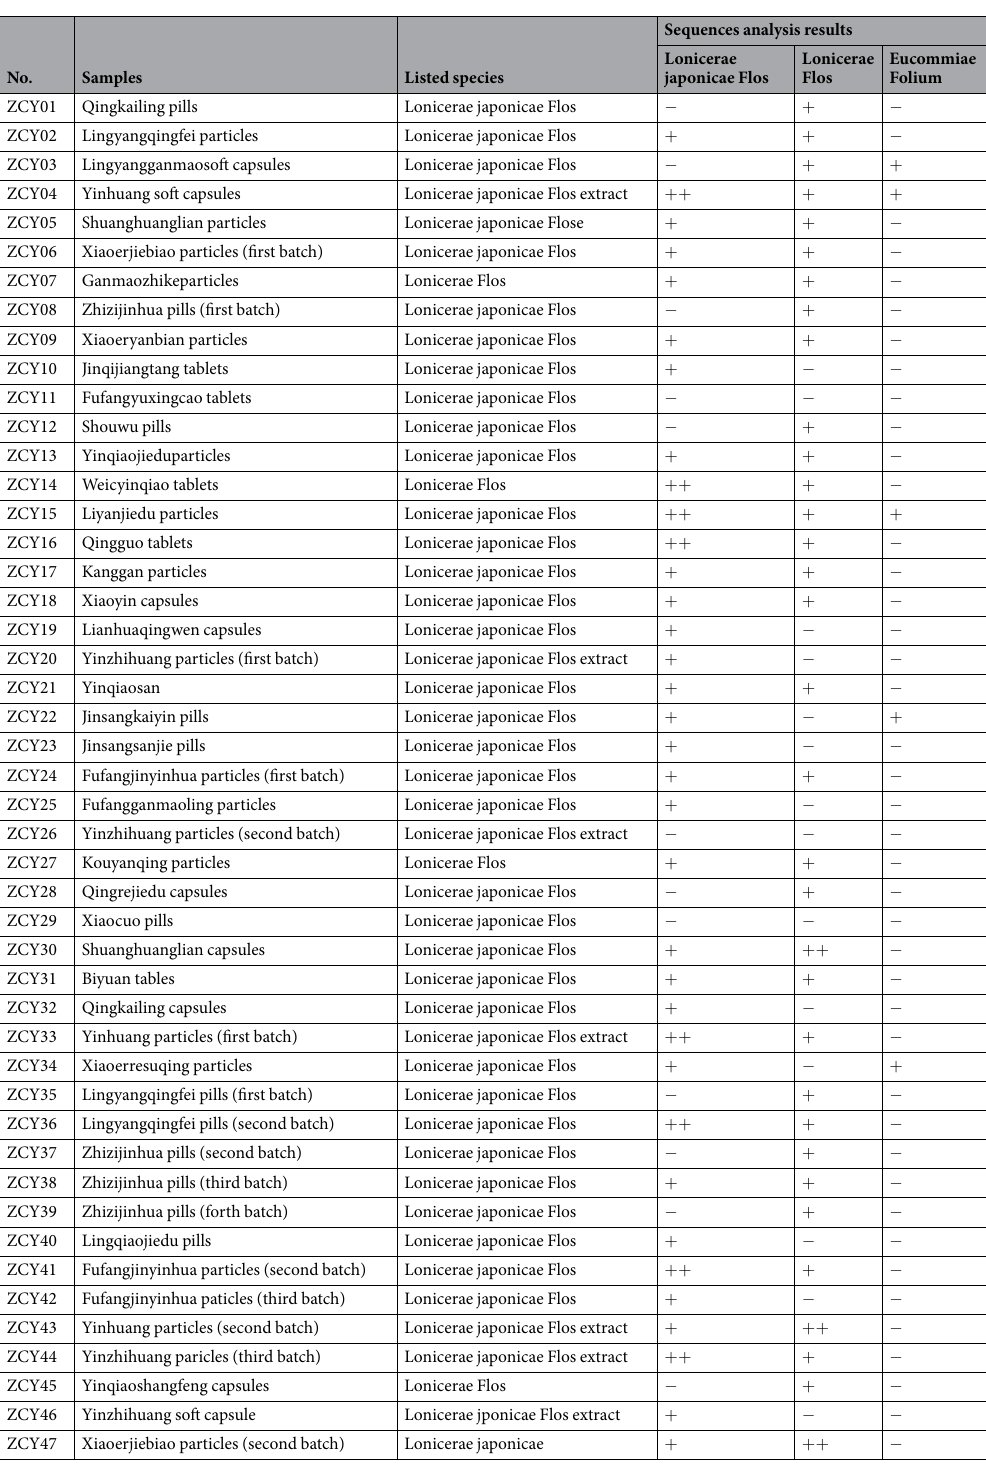
Table 2. Results of Chinese Patent Medicines’ sequences analysis. + Present; -Absent. ++ Present in greater particles (ZCY15), Qingguo tablets(ZCY16), Yinhuang particles (first batch)(ZCY33). Relative peaks are higher for the adulterant Lonicerae Flos in the following samples (examples): Lingyangqingfei particles (ZCY02), Shuanghuanglian particles (ZCY05), Yinqiaojiedu particles (ZCY13), Kanggan particles (ZCY17). Product substitution with Lonicerae Flos was found in the following samples (examples): Qingkailing pills (ZCY01), Zhizijinhua pills (first batch) (ZCY08), Shouwu pills (ZCY12). Substitution with large amounts of Lonicerae Flos, with only trace amounts of Lonicerae japonicae Flos detected within samples of Shuanghuanglian particles